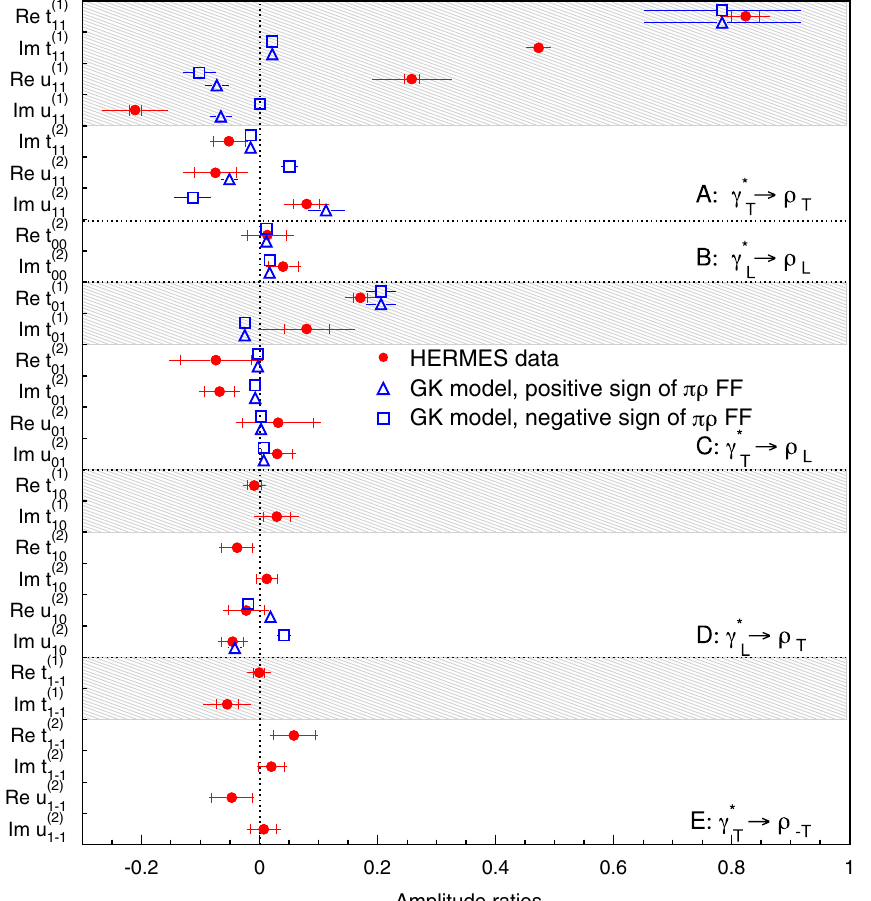
Fig. 6 Comparison of amplitude ratios determined in this paper to those calculated in the GK model, where the phase convention from Eq. (9) is taken into account. The amplitude ratios that are set to zero in the GK model are not shown. The inner ( outer ) error bars represent the statistical (total) uncertainty. An additional scale uncertainty of 8% originating from the uncertainty on the target polarization is present for ( 2 ) ( 2 ) the ratios t λ V λ γ and u λ V λ γ , but not shown. An extra scale uncertainty of